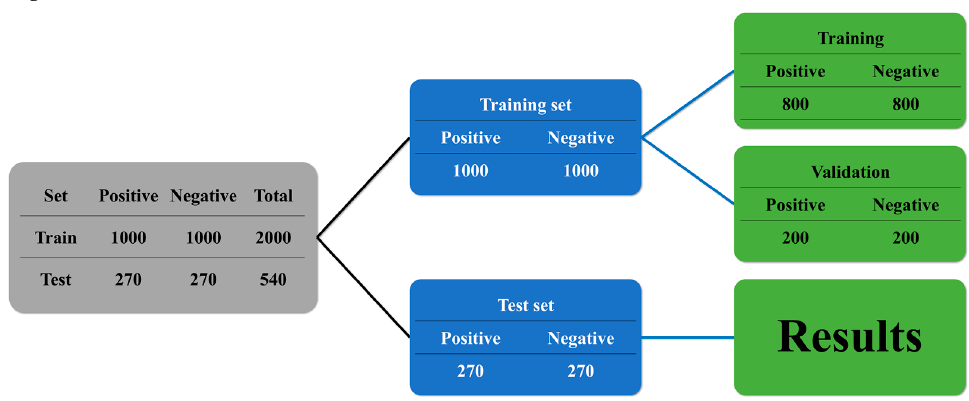
Figure 3. Composition of the training and test datasets .